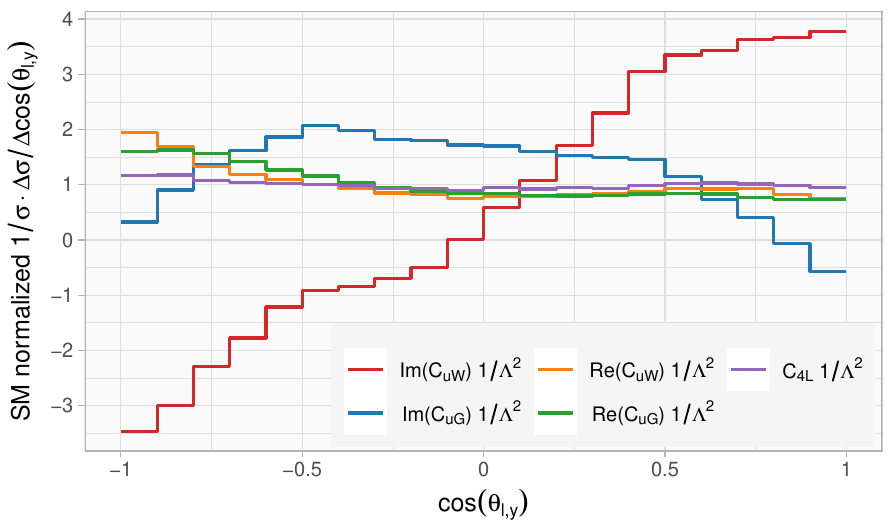
Figure 19. To itself and to the SM normalized SMEFT contributions to the cos (cid:18) l;x distribution at NLO in QCD . Results are presented for the real and imaginary parts of C 33 as for the four quark operator C 4 L .